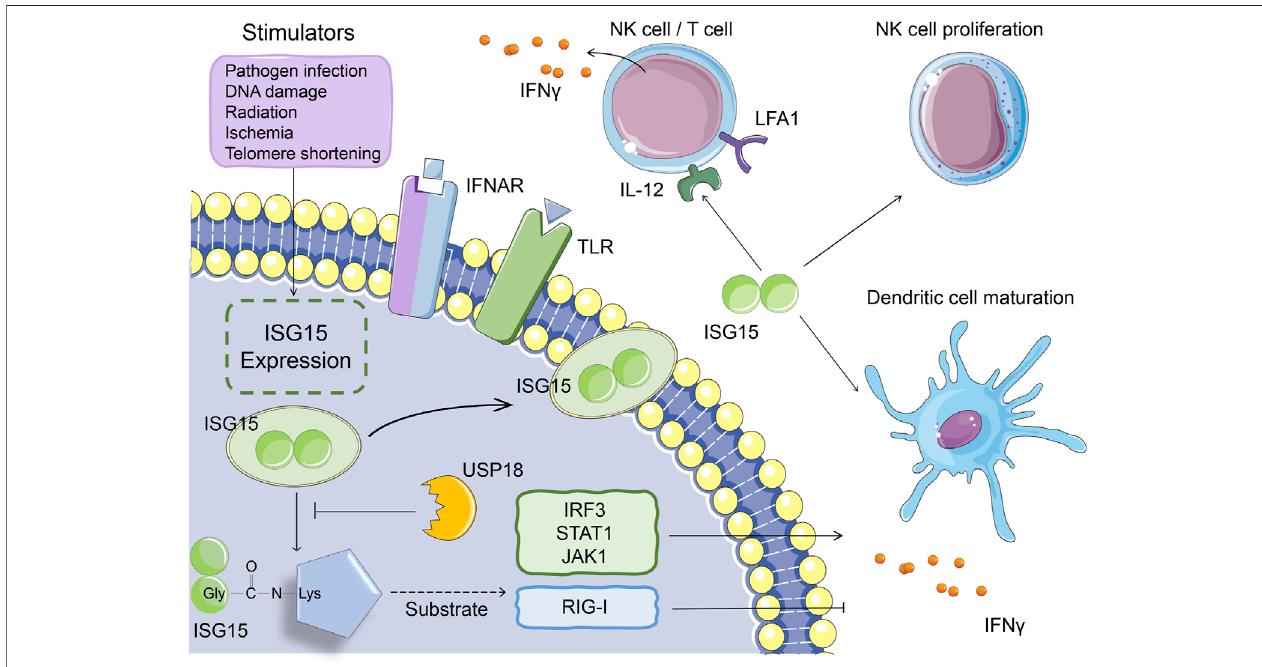
FIGURE 2 | The function of ISG15 in immune response. Under pathogenic stimuli such as viral and bacterial infections, LPS, and DNA damage, monocytes, lymphocytes, neutrophils, etc. can all secrete ISG15. Intracellular ISG15 can bind to proteins related to innate immune signaling pathways, activate IRF3, STAT1, JAK1 and other proteins, or inhibit protein activity (such as RIG-I), thereby promoting or inhibiting the secretion of IFN γ . The ISG15 secreted in vitro can bind to the LFA1 receptor on the cell surface, thereby promoting the secretion of IFN γ from NK cells and T cells. It can also induce the proliferation of NK cells and the maturation of dendritic